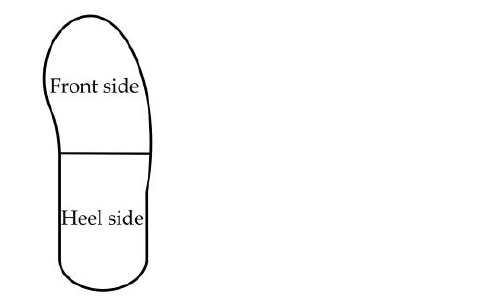
Figure 6. Plantar was divided into two regions, front side and heel side, and the plantar force was calculated for each